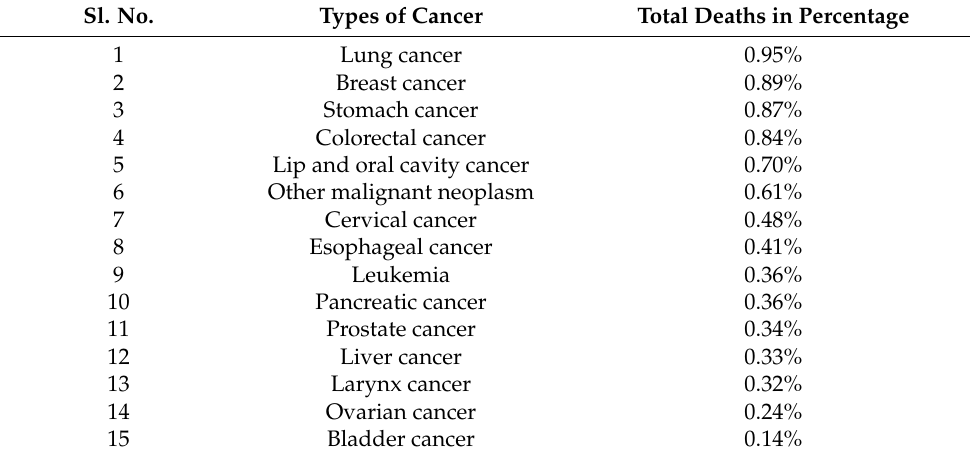
Table 1. Cancer types and total deaths from cancer in India, in 2019. Sl. No. Types of Cancer Total Deaths in Percentage 1 Lung cancer